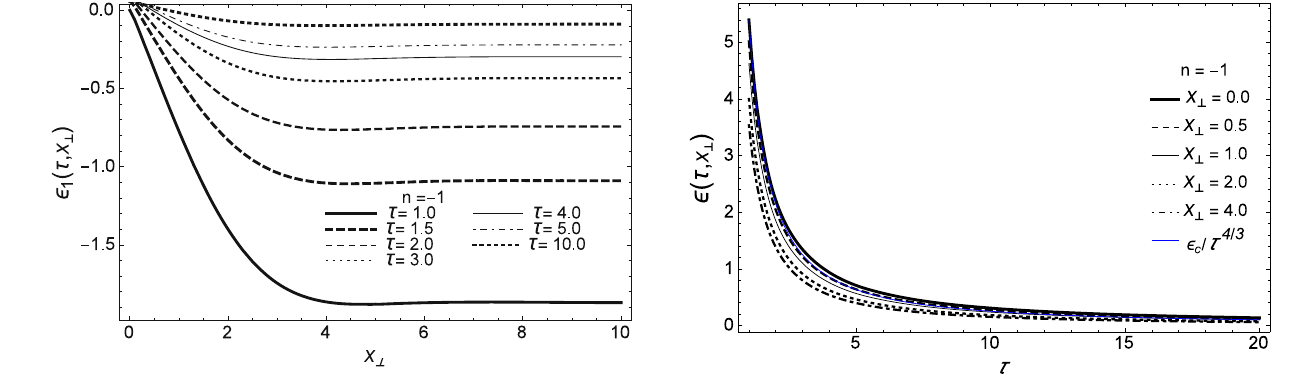
Fig. 5 (cid:5) 1 as a function of x ⊥ for different values of τ